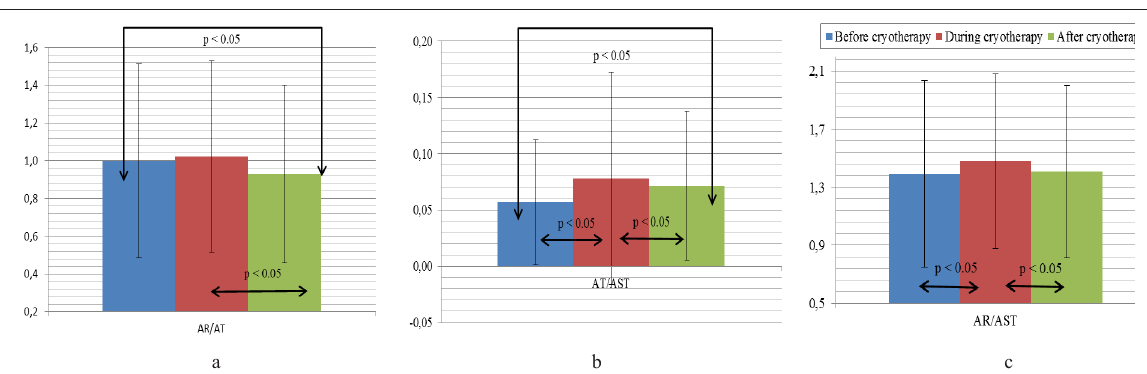
Figure 4. Changes in the concanetanations of ECG parameters (amplitudes)